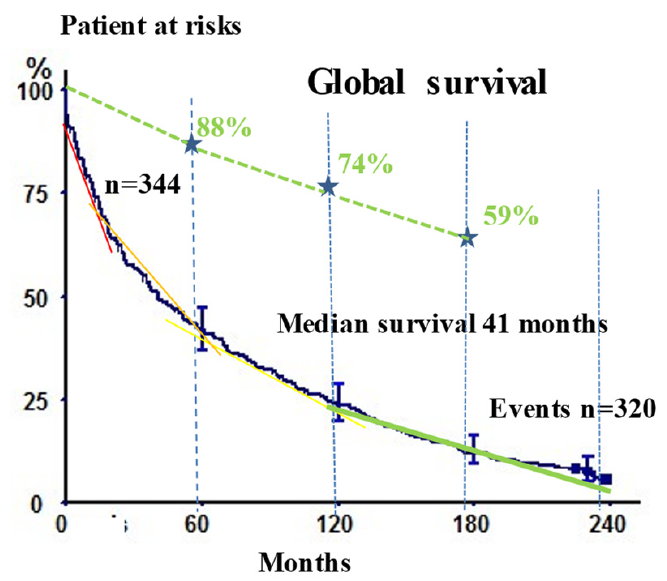
Figure 1. Kaplan–Meier overall survival analyses of the study cohort of 345 patients, with confidence intervals, at 5, 10, 15, and 20 years. Mean age of patients at implantation was 62.1 years. The dotted green lines show the survival rates at 5, 10, and 15 years in the control population of the match for age but without tumor. For this control group of patients, survival rates were: 88% at 5 years, 74% at 10 years, and 59% at 15 years, as reported in an earlier study [9]. Very interestingly, after 10 years, the survival rates in patients having NSCLC (solid green line) were very similar and parallel to people without (dotted green lines). This means that after 10 years and up to 20 years, operated patients had reached the classical mortality rate of non-operated patients. Table 2 shows the results of univariate survival analyses of 16 relevant clinical pa- rameters. In our study at 20 years, increased age was strongly associated with poorer long-term survival ( p = 0.0042) (Figure 2(A2)), while only a weak link with the sex of the patient ( p = 0.059) was observed in this data set (Figure 2(A1)). With regard to to- Table 2. Impact of clinical, pathological, and biological variables following univariate analysis on bacco consumption, neither smoking status at surgery ( p = 0.24) nor smoking cessation very long-term survival rates for the 345 study patients, obtained by Kaplan–Meier estimator, and before surgery ( p = 0.39) impacted the outcome. At the same time, chronic bronchitis comparison for each group of factors using the log-rank method censoring at 20 years.